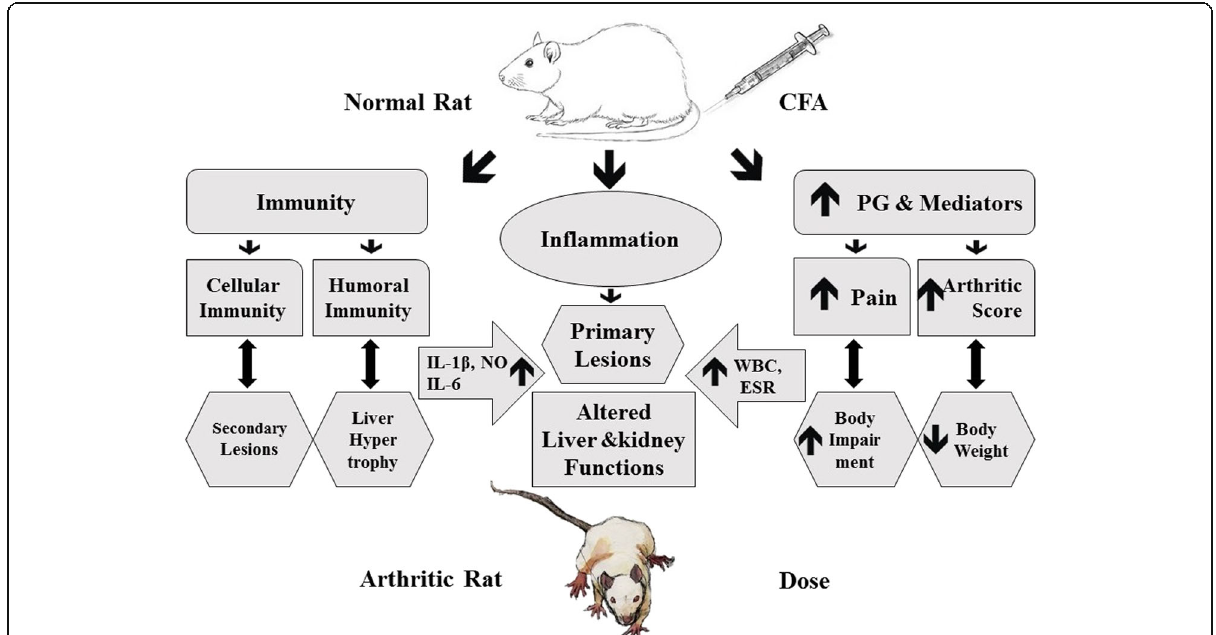
Fig. 9 Proposed mechanism and pathway of CFA-induced arthritis showing onset of disease and various local and systemic variations in the body of experimental rat. The pathways have been reproduced by Muhammad Majid (1st author) from already published paper [56]